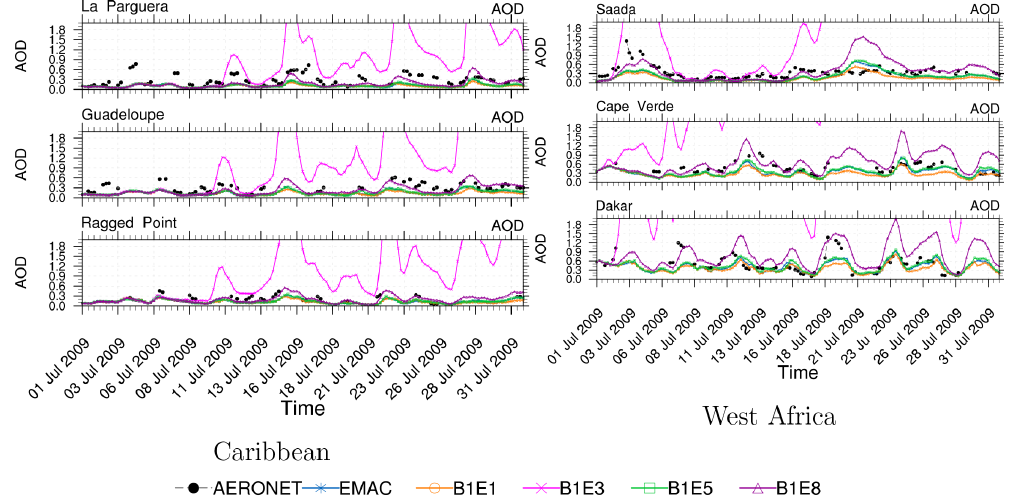
Figure 8. EMAC and AERONET AOD for the western African (right) and Caribbean (left) sites based on different dust emissions (Table